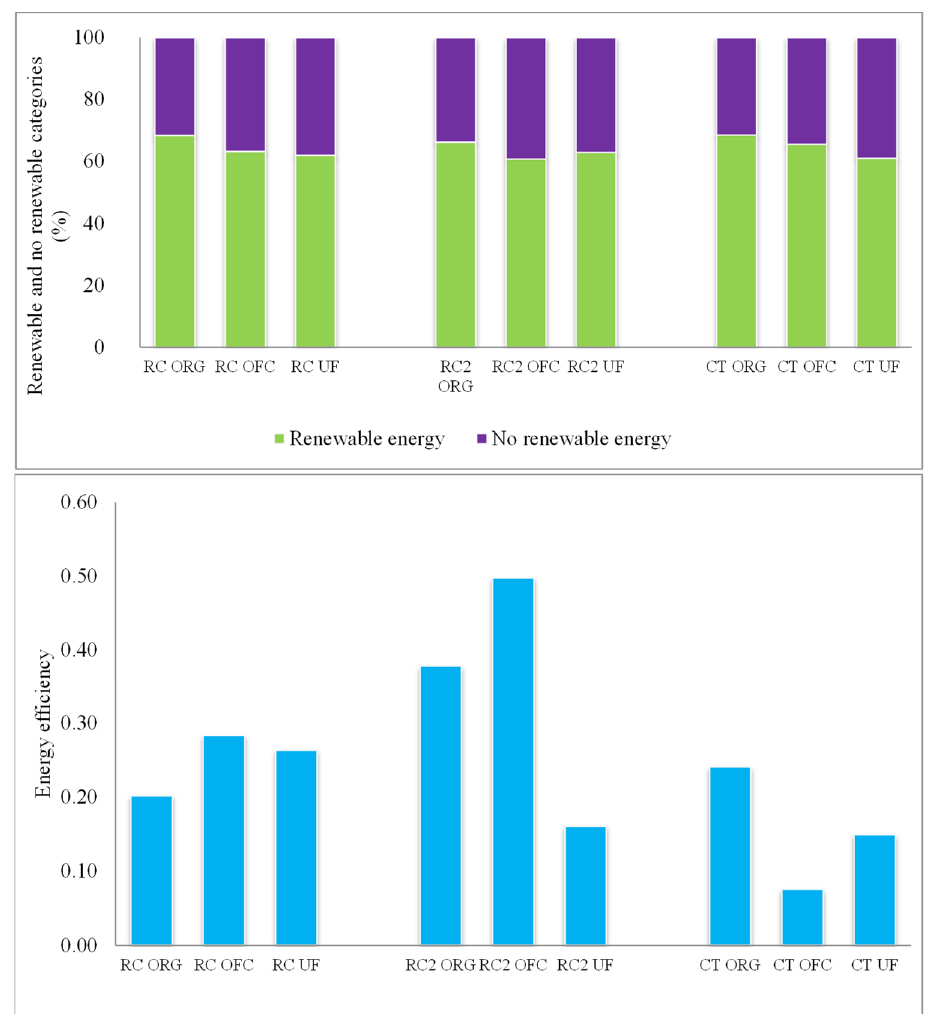
Figure 4. Energy efficiency and energy input divided by renewable and no renewable categories (%) in the different analyzed systems. RC = mix of vetch-oats; RC2 = mix of vetch-rice; CT = no cover crops; ORG = organic commercial fertilizer; OFC = on-farm compost; UF = unfertilized control. Figure 5 shows that the carbon loss, derived by the sum of the CO 2 emitted in the cultivation processes and the CO 2 eq. generated by the N 2 O emissions, was, on average, higher in the RC and RC2 treatments than in UF ( − 10.4% compared to the average of RC and RC2), and in ORG compared to OFC ( − 6% compared to ORG) and UF treatments ( − 46% compared to ORG). The total C stocks, which is the sum of the C stocked in the products with C in the plant residues and in the cover and weeds, were higher in RC2-OFC, with a value of 3570.9 kg C ha − 1 year − 1 , RC-OFC and RC2-ORG ( − 6.7 and − 11.9% compared to RC2-OFC, respectively), whereas a very low value was shown by CT-OFC and CT-UF ( − 76 and − 75% compared to RC2-OFC, respectively).